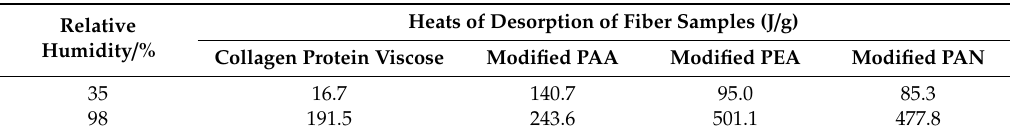
Table 4. Heats of desorption from TGA-DSC analysis.